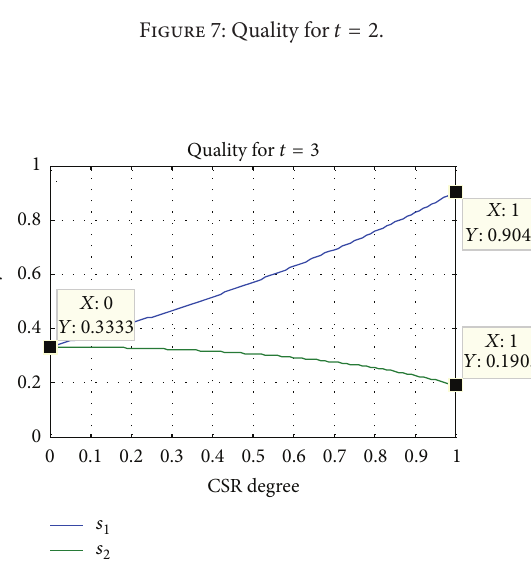
Figure 7: Quality for 𝑡 = 2 .